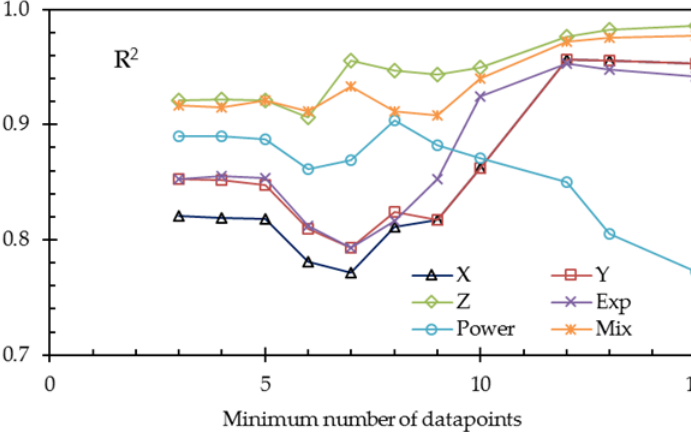
Figure 10. Mean coefficients of determination (R 2 ) for the different models. Started with 145 datasets (some containing only 3 data points) until only 3 datasets remained (each with 15 data points).